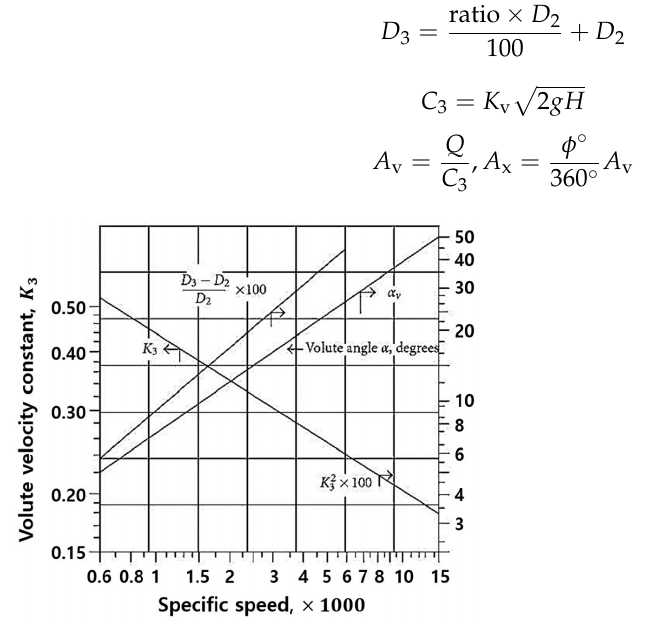
Figure 6. Design constants of volute by Stepanoff